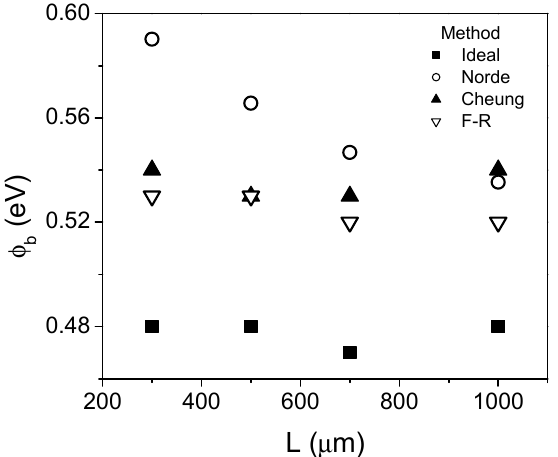
Figure 2. Comparison of the extracted values of the barrier height using the different methods.